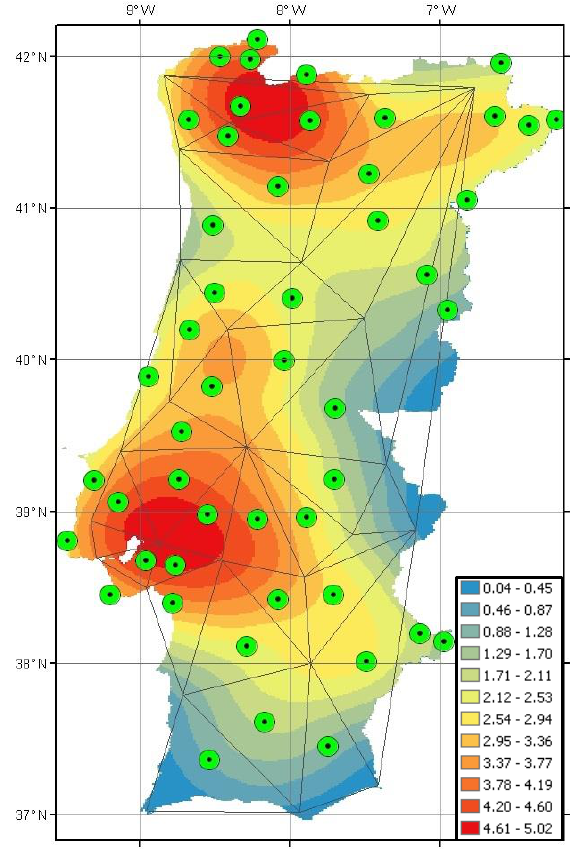
Figure 1. Network map with a kernel density of the CORS Figure 2. Location of the points observed along with the